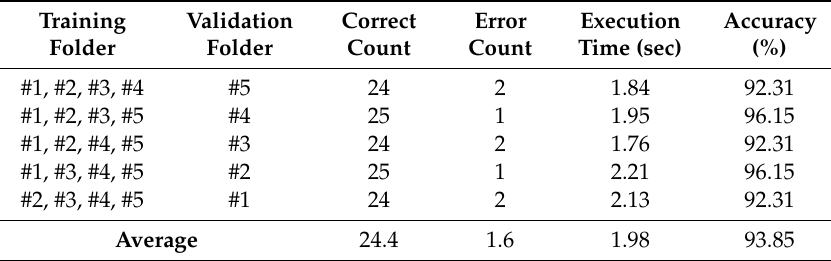
Table 2. k -fold cross-validation for DTW approach.